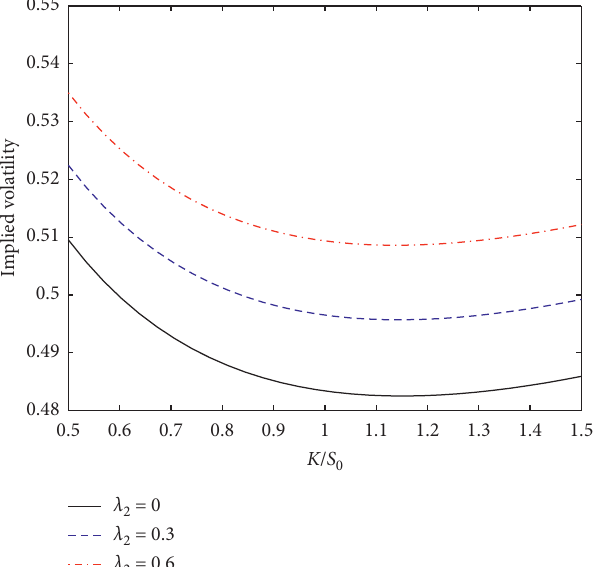
Figure 2: Implied volatility for different values of λ